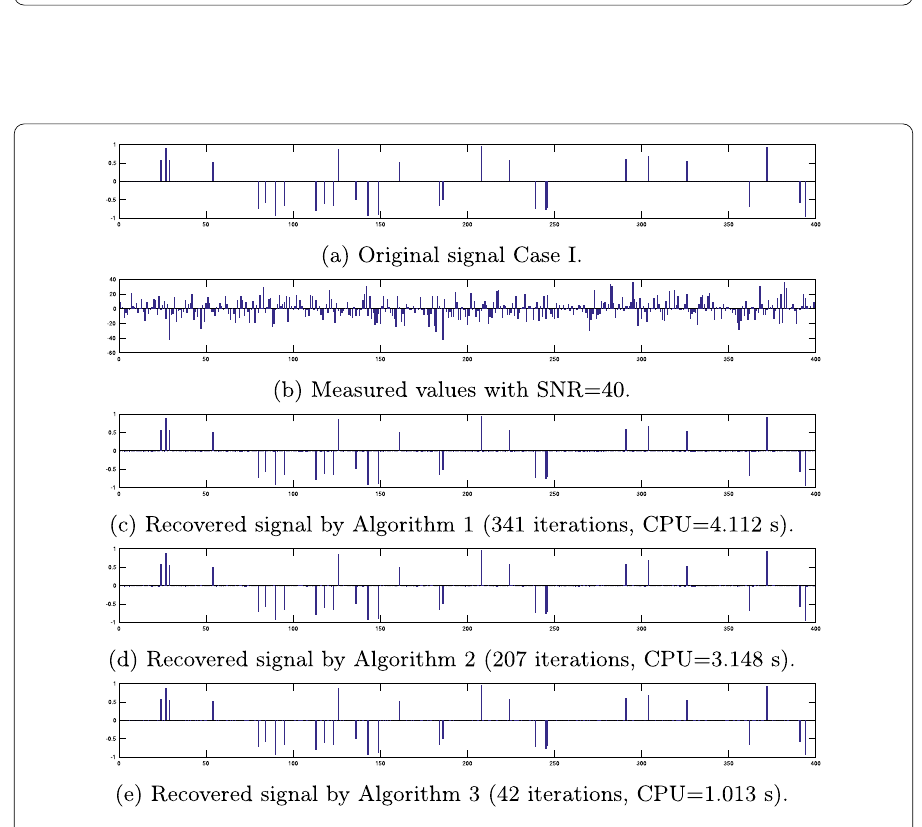
Figure 9 Computational results for Example 4.5 Case